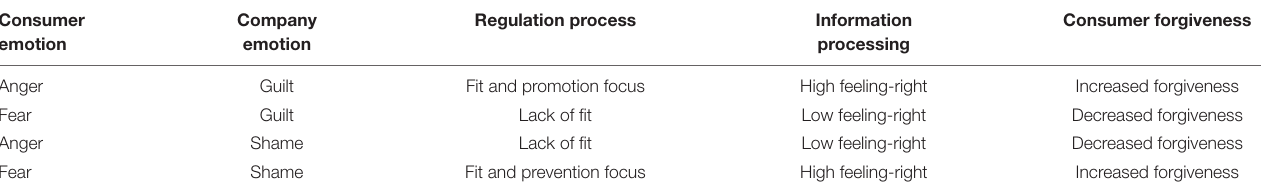
TABLE 1 | Hypothesized interaction among consumer emotion, company emotional frame, regulation process, feeling-right, and consumer